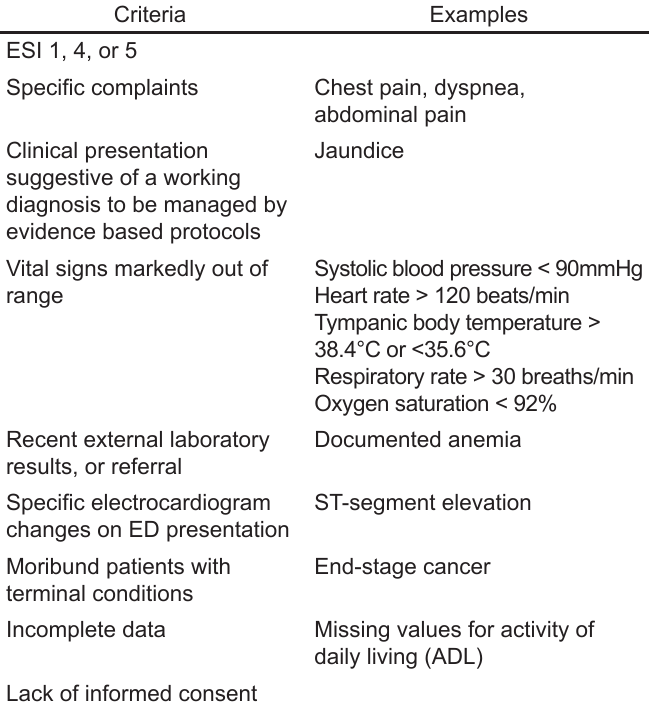
Table 1. Exclusion criteria in study assessing the predictive power of triage in older patients presenting with non-specific